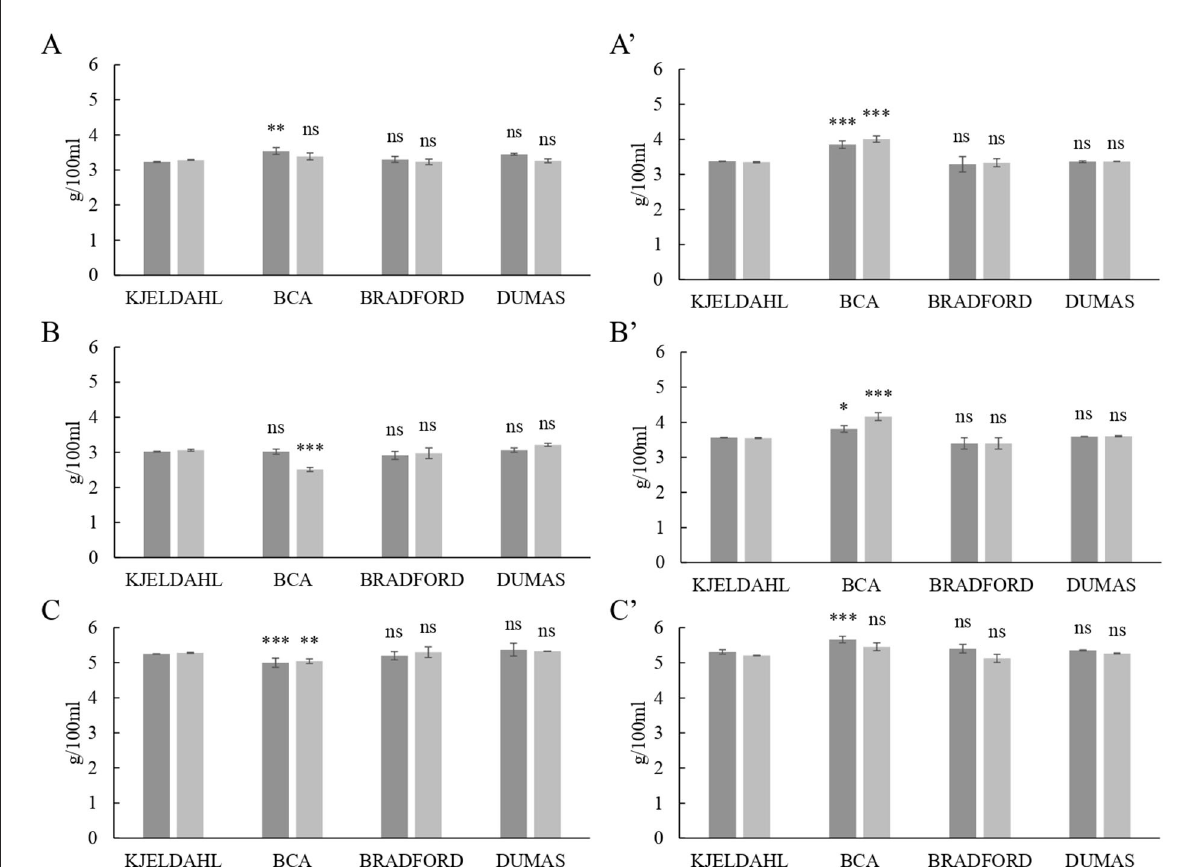
FIGURE2 Comparison of protein levels in milk (g / 100mL) obtained by Kjeldahl official reference method with the contents determined by the bicinchoninic acid assay (BCA), the detergent compatible Bradford assay and the Dumas method. (A) Cow’s skimmed milk, (A’) cow’s